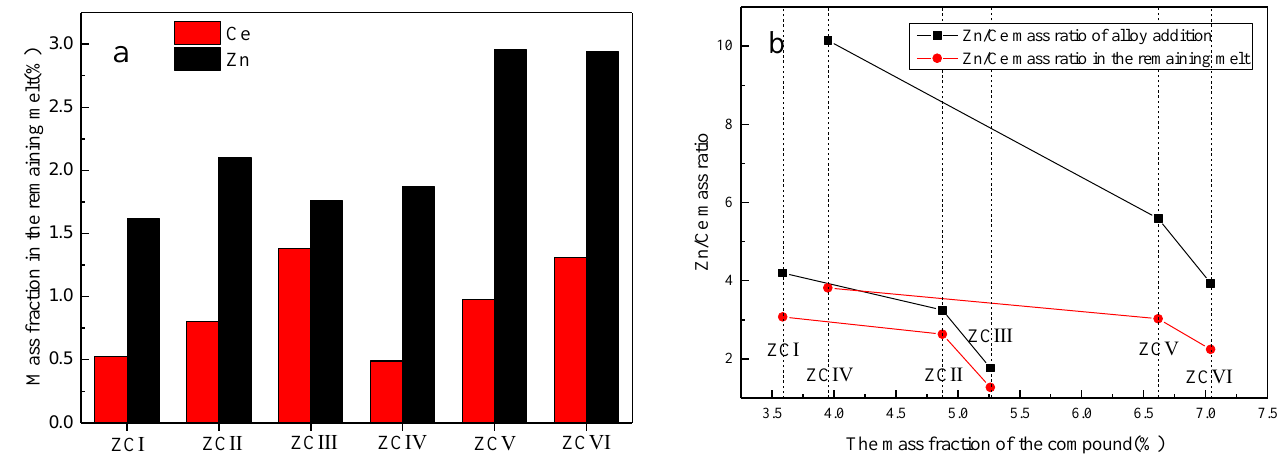
Figure 13. Mass fraction of elements in the remaining melt. ( a ) Calculated mass fraction of Ce and Zn elements in the remaining melt, ( b ) Correspondence between the Zn/Ce mass ratio and the compound mass fraction in the alloy and the remaining melt.